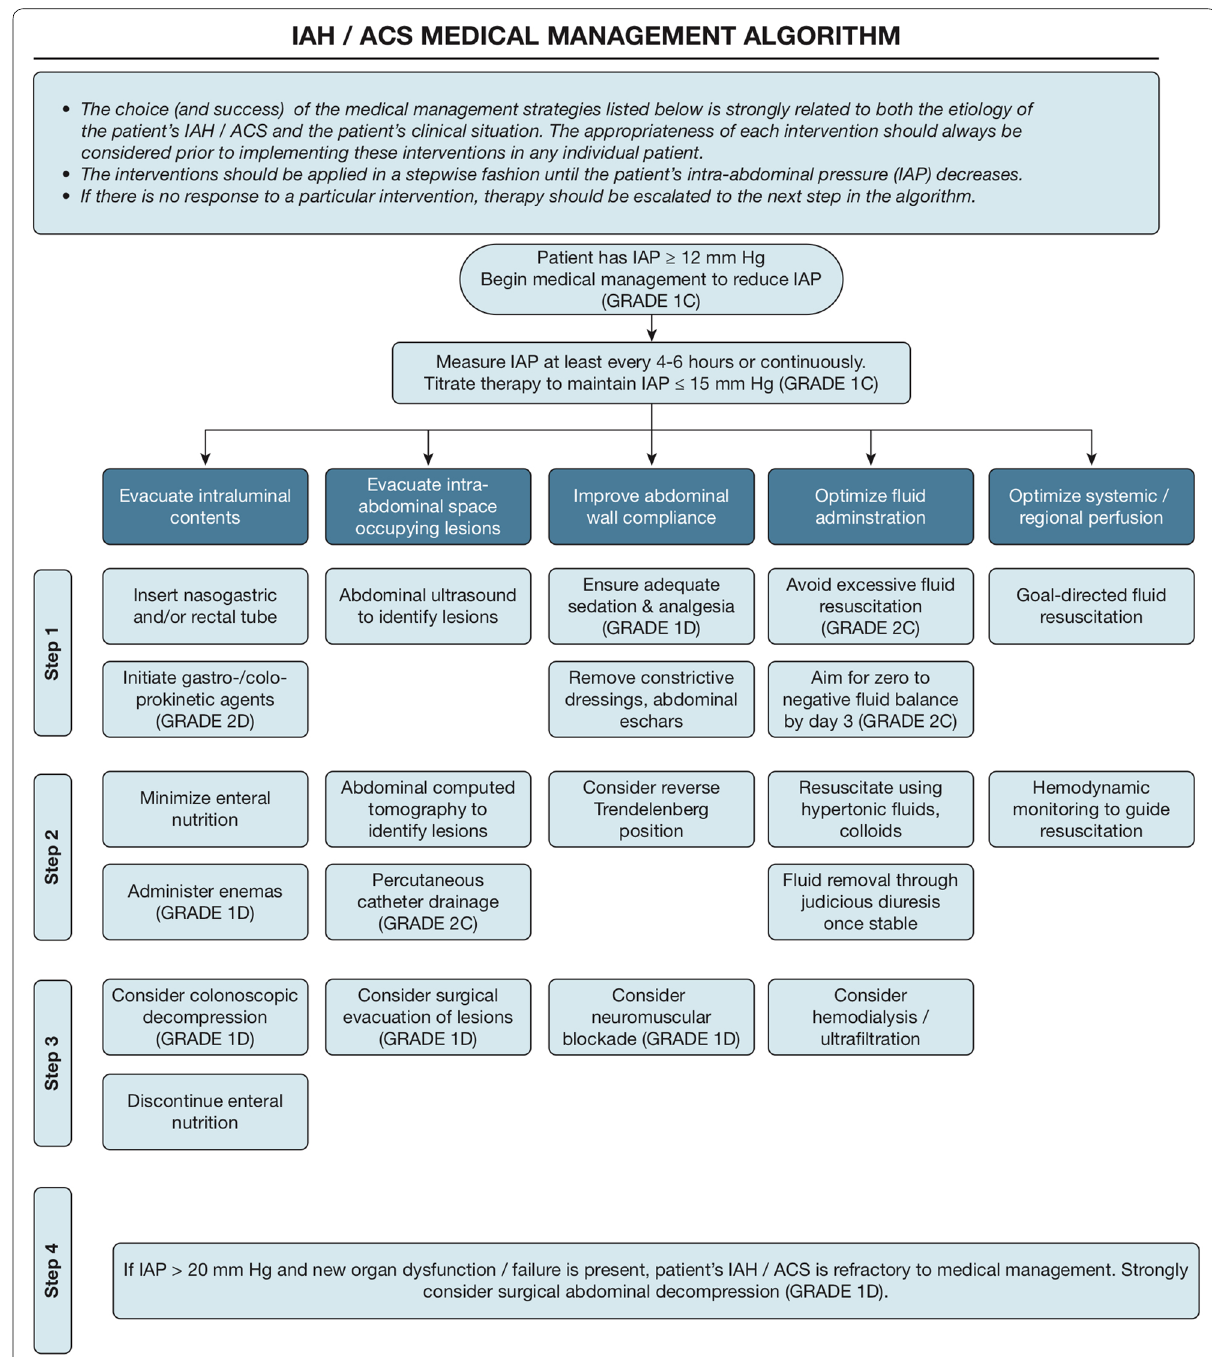
Fig. 5 WSACS 2013 Intra-Abdominal Hypertension/Abdominal Compartment Syndrome Medical Management Algorithm. Quality of evidence for each recommendation and strength of recommendation is rated along a four-point ordinal scale in accordance with Grading of Recommendations Assessment, Development and Evaluation (GRADE) guidelines (http://www.grade worki nggro up.org), in which each evidence grade is symbolized by a letter from D to A: very low (D), low (C), moderate (B), and high (A) and strength of recommendation is given by a number: strong (1) and weak (2). ACS abdominal compartment syndrome, IAH intra-abdominal hypertension, IAP intra-abdominal pressure. ©Copyright by WSACS, the Abdominal Compartment Society (http://www.wsacs .org). Figure reproduced and adapted with permission from Kirkpatrick et al.